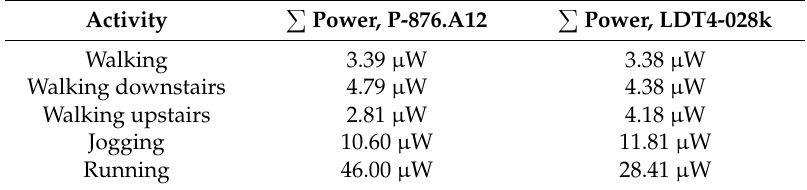
Figure 7. The sums of the mean values of the calculated power output on each joint for the activity performed. Error bars represent the standard deviation. Table 8. Results of the sum of the power grand mean values measured at all of the joints for each activity.